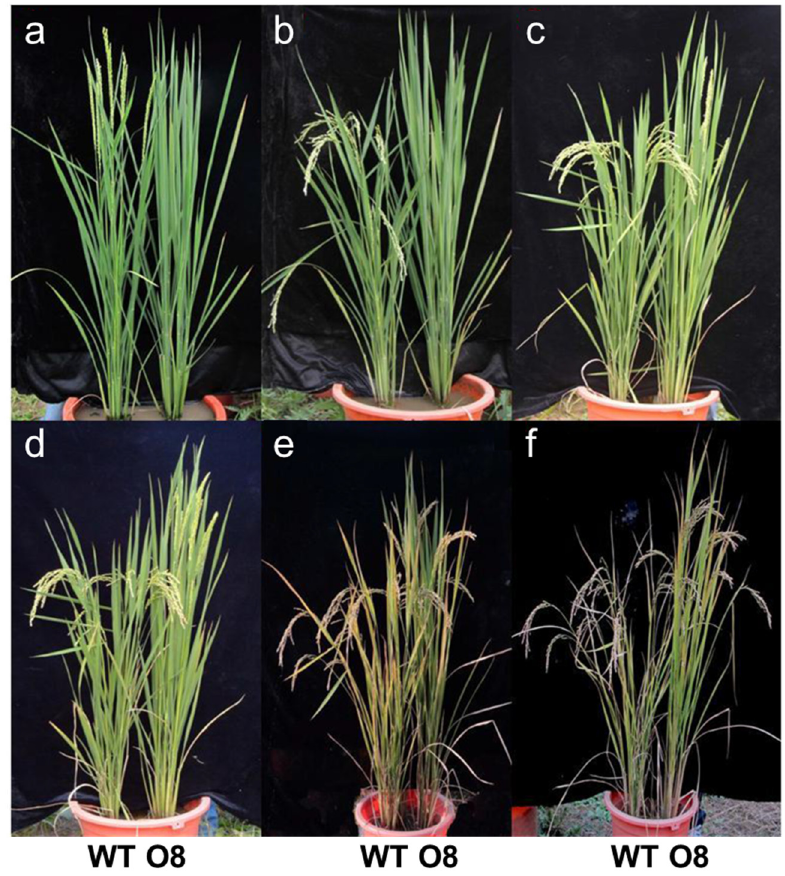
Figure 1. The phenotype difference between WT and O8 in late growth stage. ( a ) 76 days after transplant; ( b ) 84 days after transplant; ( c ) 88 days after transplant; ( d ) 98 days after transplant; ( e ) 120 days after transplant; ( f ) 140 days after transplant.